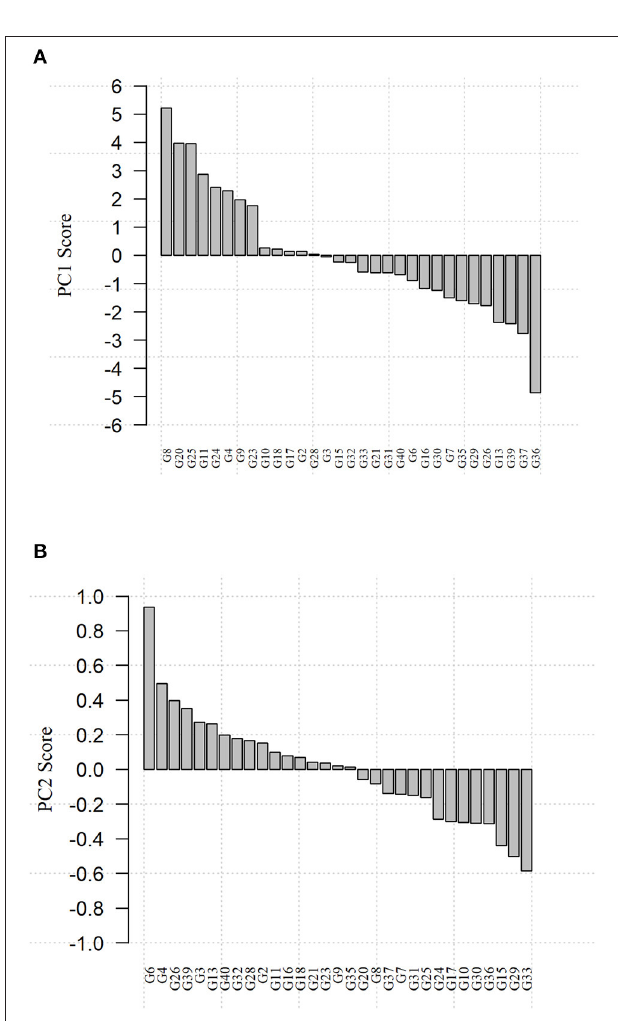
FIGURE 3 | Scores of PC1 (A) and PC2 (B) for data from 31 Coffea arabica elite genotypes processed by wet process according to the scores of sensory attributes and the final